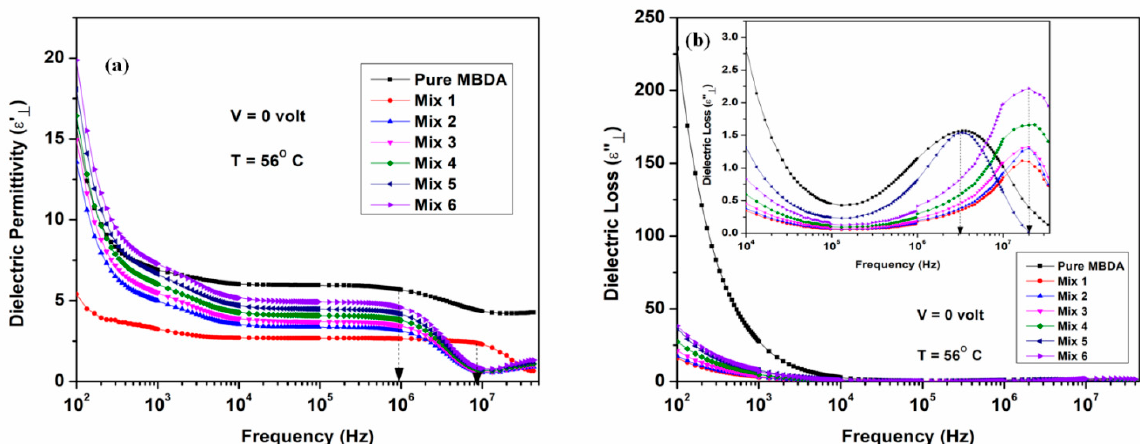
Figure 5. ( a ) Variation of dielectric permittivity versus frequency at 0 volt applied bias and 56 ◦ C temperature for pure